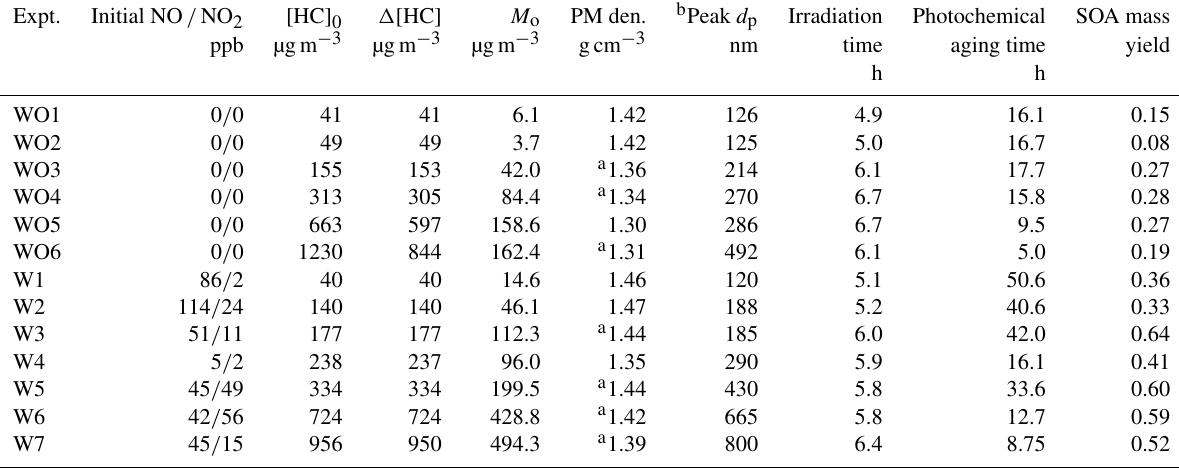
Table 2. Chamber SOA data; WO indicates experiments without added NO x , and W indicates experiments with added NO x . Expt.